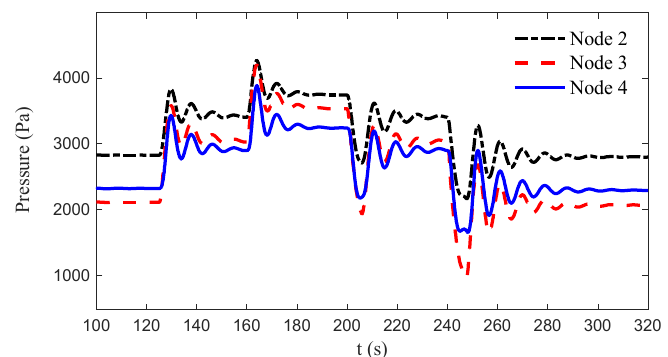
Figure 8. Variations of pressure during the MT output adjustment process.